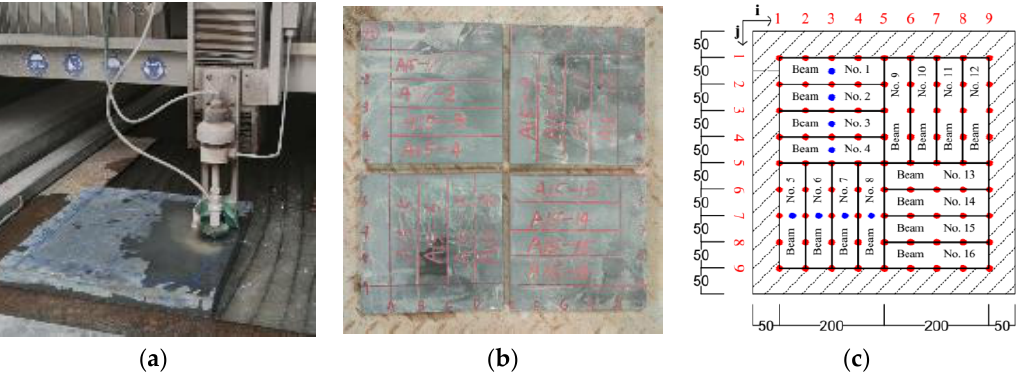
Figure 13. Concrete plate cutting. ( a ) Water blade cutting; ( b ) concrete plate after cutting; and ( c ) schematic graph.